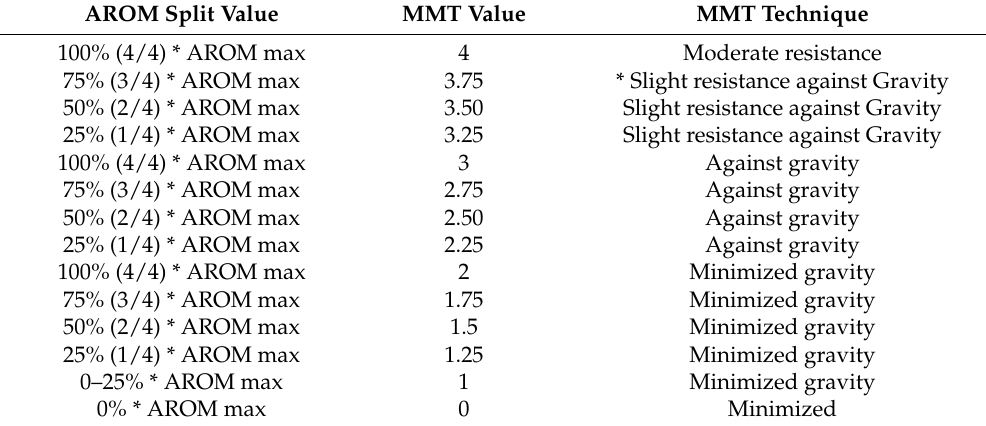
Table 4. Adapted MMT based on